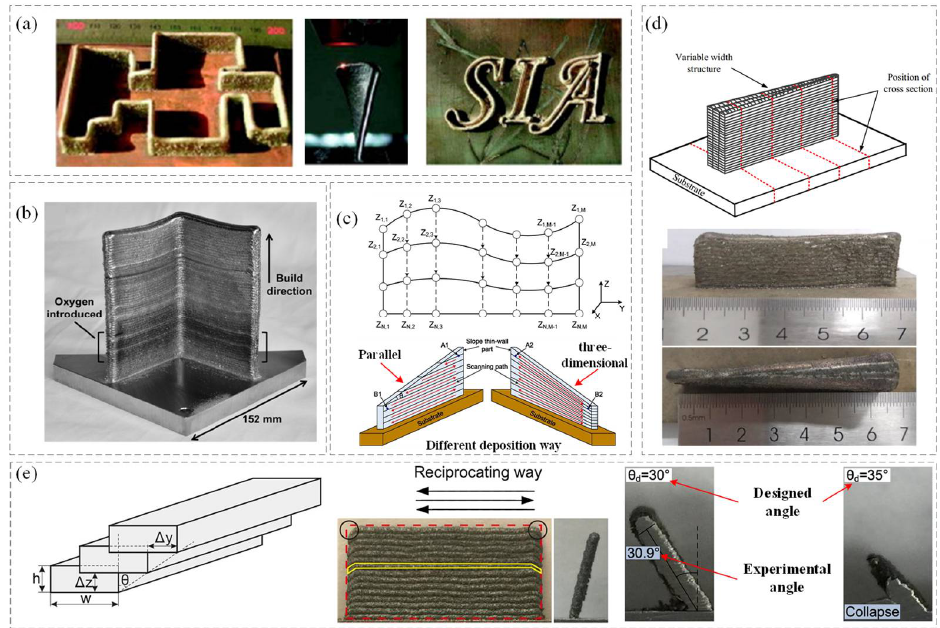
Figure 3. ( a ) Images of 316L thin-wall parts with complex structures (Reprinted from ref. [14], copyright (2013), with permission from Elsevier); ( b ) Image of deposited cruciform thin-wall (Reprinted from ref. [67], copyright (2015), with permission from Elsevier); ( c ) 316L slope thin-wall part fabricated using parallel and three-dimensional deposition way (Reprinted from ref. [26], copyright (2020), with permission from Elsevier); ( d ) Schematic and samples of typical variable width thin-walled structures [52]; ( e ) Schematic and 316L thin-walled overhang structures (Reprinted from ref. [68] copyright (2018), with permission from Elsevier).